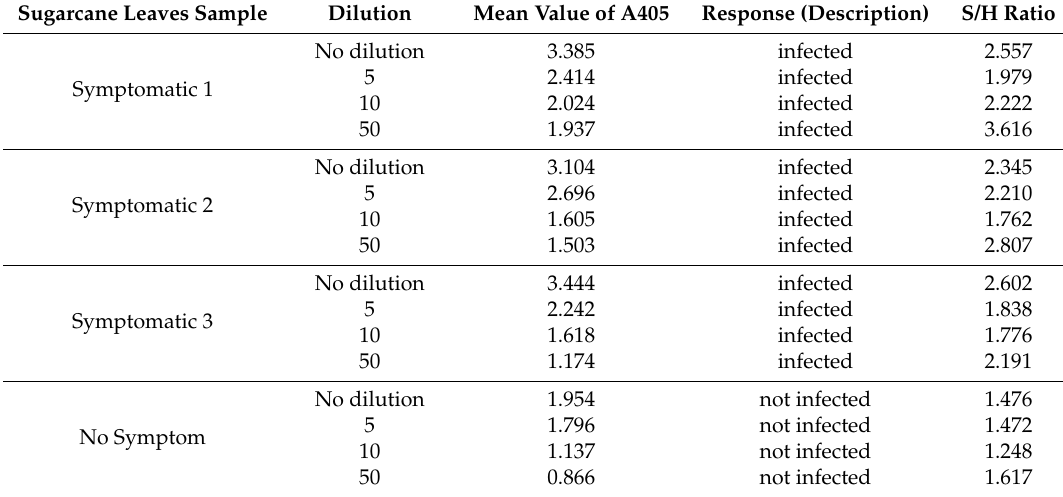
Table 1. Indirect-ELISA analysis for detection of the SCMV infection in sugarcane leaves. The ELISA analysis was conducted using the S5 antiserum and a series dilution of the protein samples extracted from healthy and symptomatic leaves.